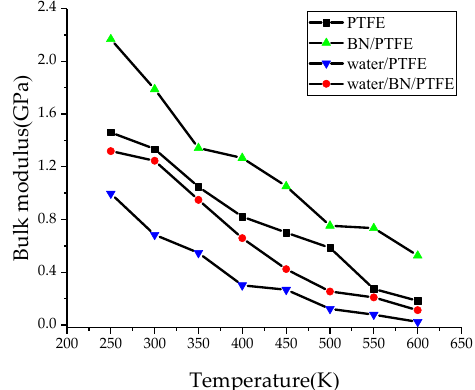
Figure 5. Shear modulus versus temperature.